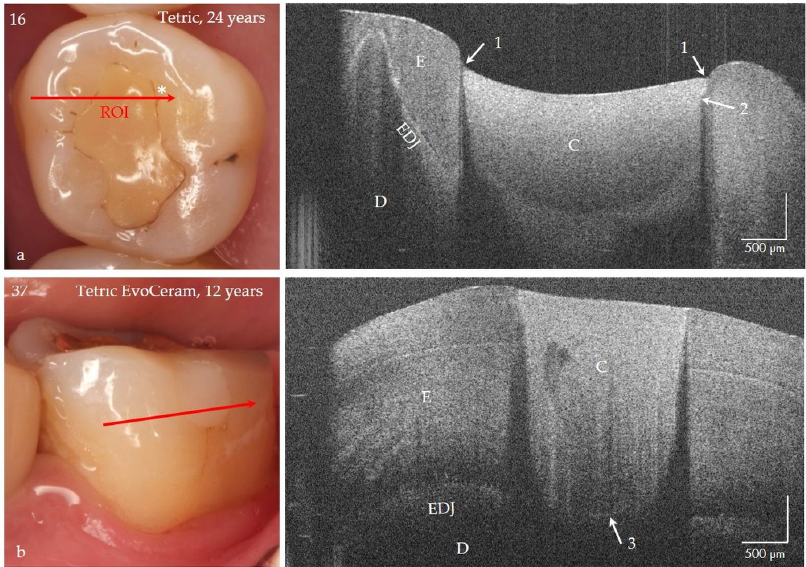
Figure 15. Class I and V composite restorations (C) in teeth 16 and 37 after 24 and 12 years of clinical function, imaged with OCT from the occlusal ( a ) and vestibular view ( b ). ( a ) The surface of the composite restoration (Tetric, adhesive #) shows negative steps at the restoration margins (arrows 1). The marginal discoloration (*) can be explained by the short interfacial marginal gap and not by caries adjacent to the restoration margin (secondary caries) (arrow 2, bright line). Beyond that the bonding interface is still intact after 24 years (no bright signal lines) and the material is homogeneous. ( b ) At the floor of the 12 ‐ year ‐ old restoration (Tetric EvoCeram, adhesive #) a short interfacial gap (3) is indicated, the progression of which can be monitored. Compared to tooth 16, the restoration margins are flat, and the material exhibits inhomogeneities. Enamel (E), dentin (D), the enamel ‐ dentin junction (EDJ). The red arrows mark the section planes of the OCT cross ‐ sectional images. The vertical scales are related to the refractive index n = 1.0 (see remark in Figure 4). Figure 16. Chromasit ® inlay on tooth 24 after 22 years of clinical service. The OCT ‐ B scan of the tooth ‐ restoration interface shows an extended marginal and deep interfacial gap (position 2, bright signal line) without signs of secondary caries. At and beneath the enamel ‐ dentin junction, a bright zone indicates a carious lesion at the tooth ‐ composite contact zone or a cracked zone in the bonding composite (C/L 1?). Gap 1 is the gap between the teeth (short bright signal line). The restoration materials C1 (dentin color) and C2 (enamel color) contain single bubbles (B). A proximal lesion L 2